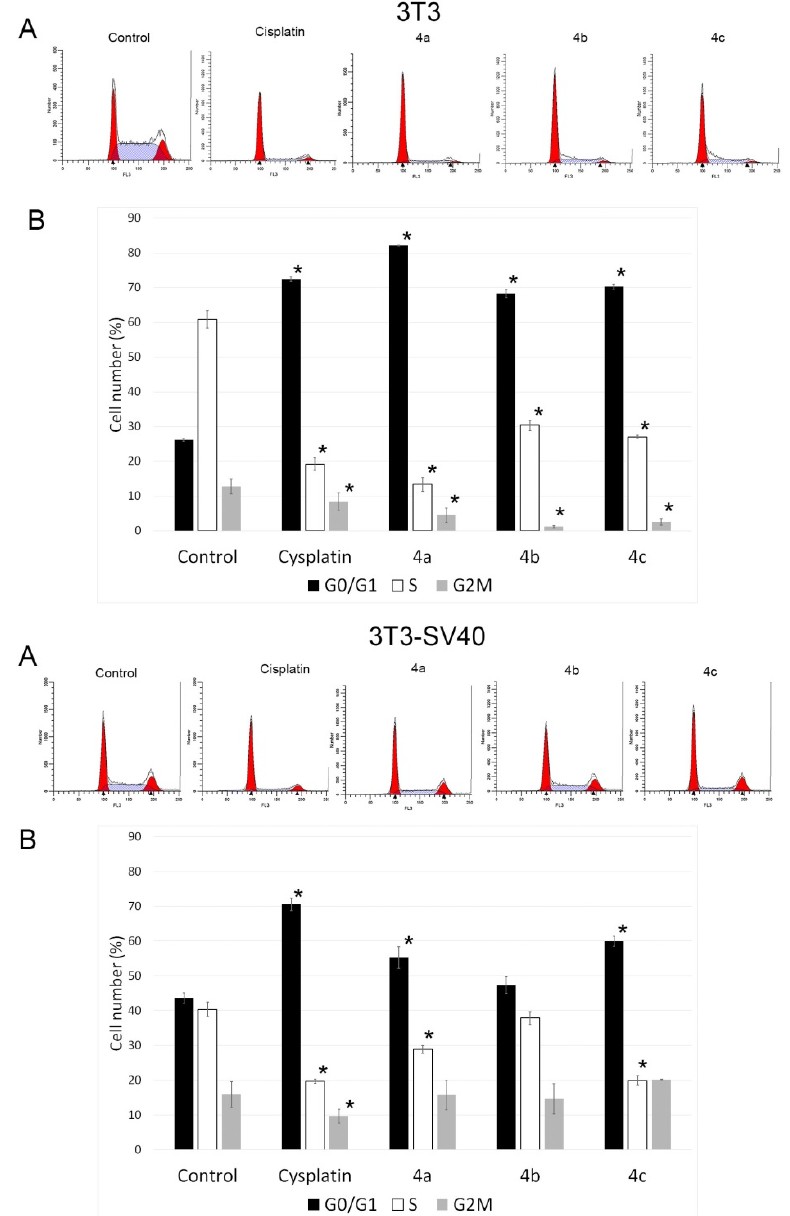
Figure 2. Effect of spiro-fused [3-azabicyclo[3.1.0]hexane]exindoles derivatives 4a – c and cisplatin on the distribution of 3T3 and 3T3 SV40 cells in the cell cycle. The most typical histograms ( A ) of distribution of cells in the cell cycle are presented (3T3A and 3T3 SV40A). The graphs 3T3B and 3T3 SV40B (B) demonstrate the average distribution of the cells in the cell cycle based on 3 replicates in each experiment, given as the mean ± SD values. * p ≤ 0.05.